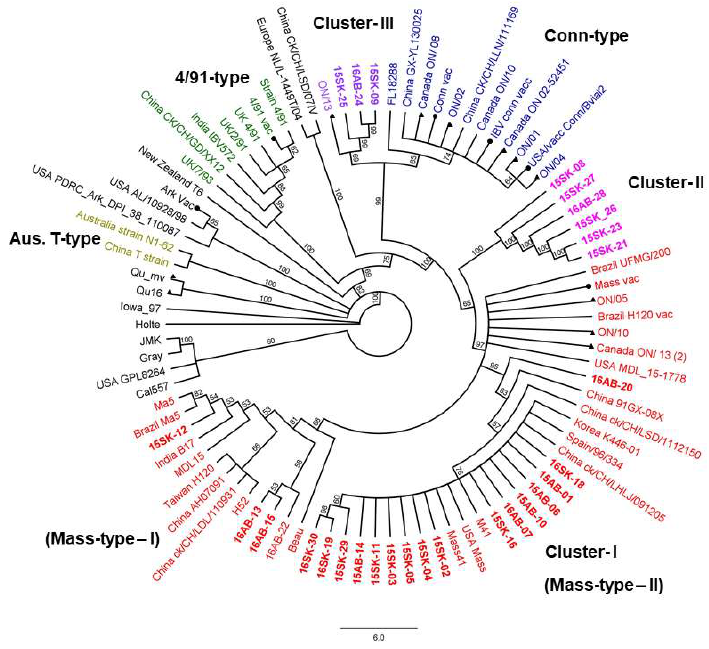
Figure 2. Maximum likelihood phylogenetic tree of IBV S1 based on deduced amino acid sequences. The bootstrap support is shown for each node (current study strains are color-coded and depicted in bold; vaccine strains are marked with ●; Canadian field strains are marked with ▲ ; IBV reference clusters and sub-clusters have been color-coded). Scale bar indicates the number of changes inferred as having occurred along each branch. Scale bar indicates the percentage of sites changing along each branch.